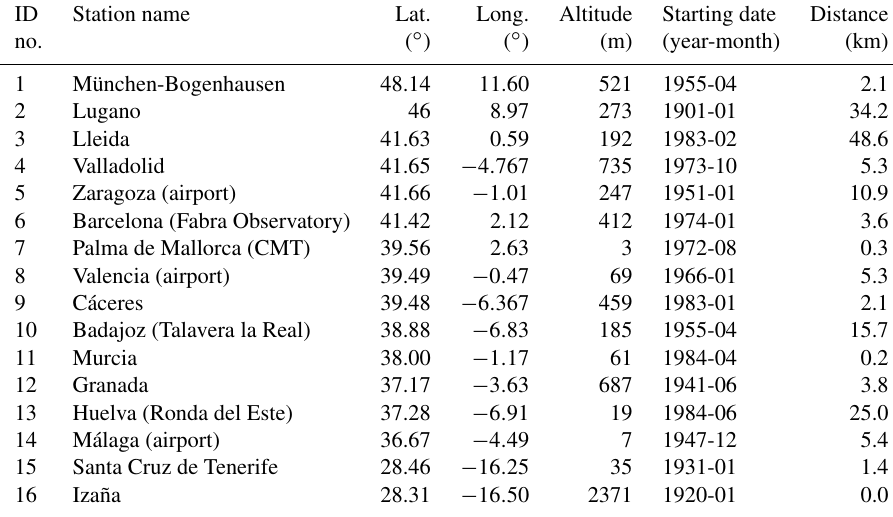
Table 2. Description of ECA&D stations used for providing SD/TCC measurements following the ID number of the station from Table 1. The distance between the ECA&D and AERONET station is given.